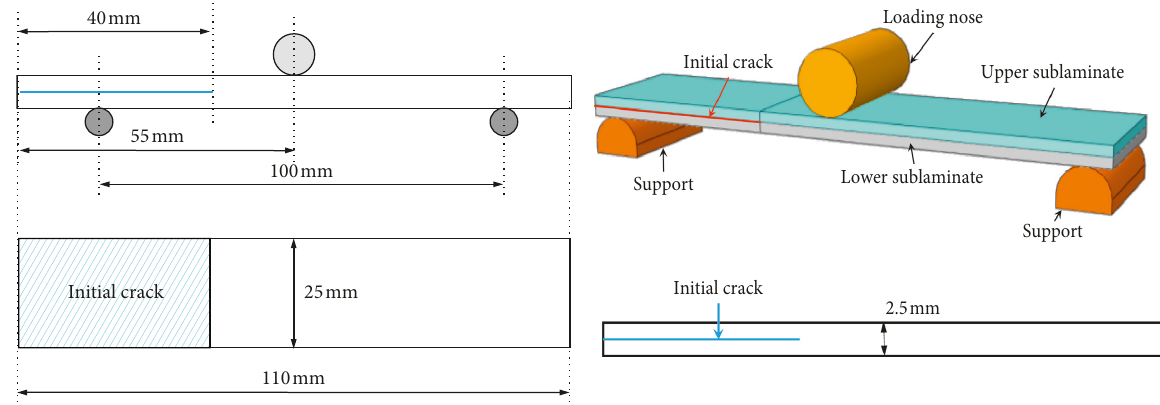
Figure 20: ENF: geometrical